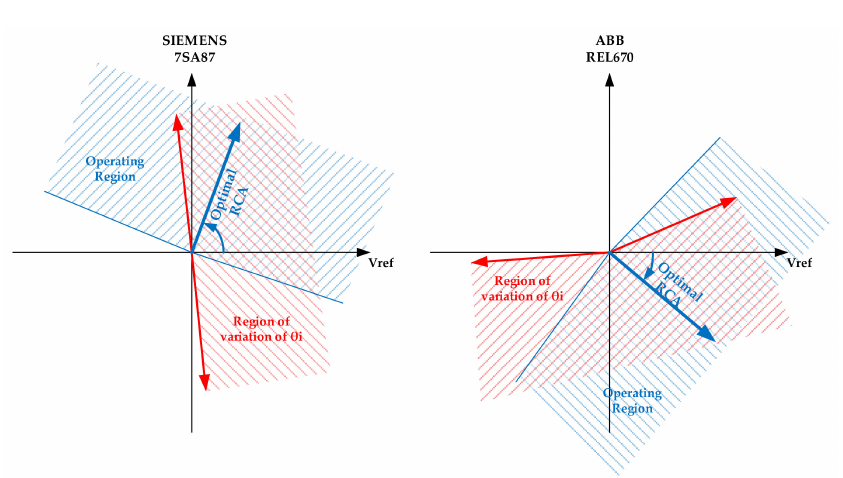
Figure 9. Graphic results for the evaluation of polarization on the directional phase overcurrent element of relays at substation SE_A of the LT_1 transmission